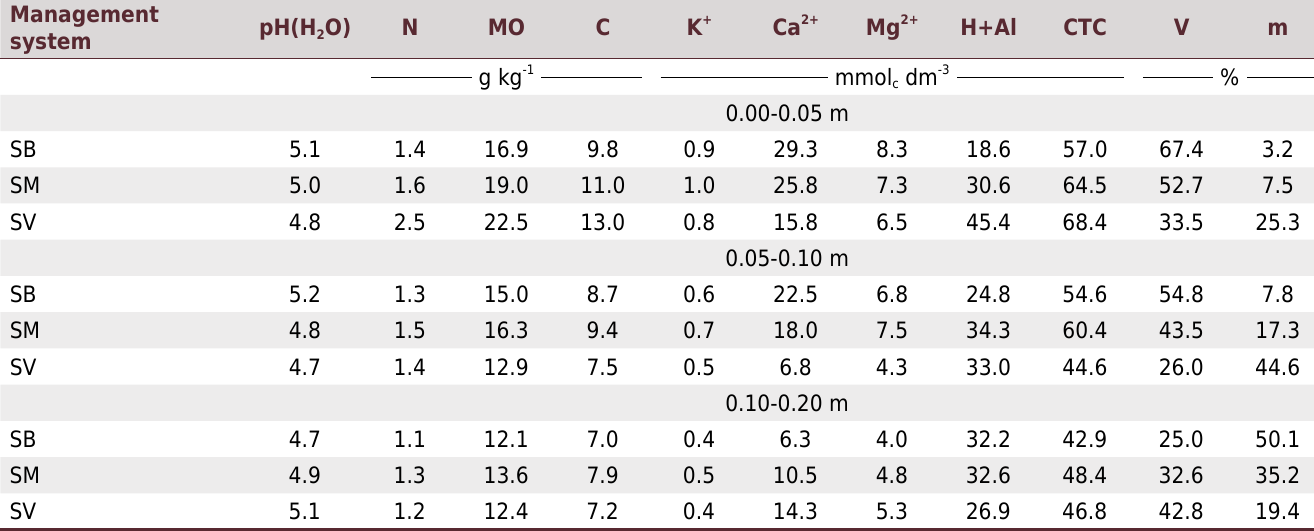
Table 1. Soil chemical properties of an Argissolo Amarelo Distrófico (Ultisol) under slash-and-burn (SB), slash-and-mulch (SM) and secundary vegetation (SV) systems at different depths